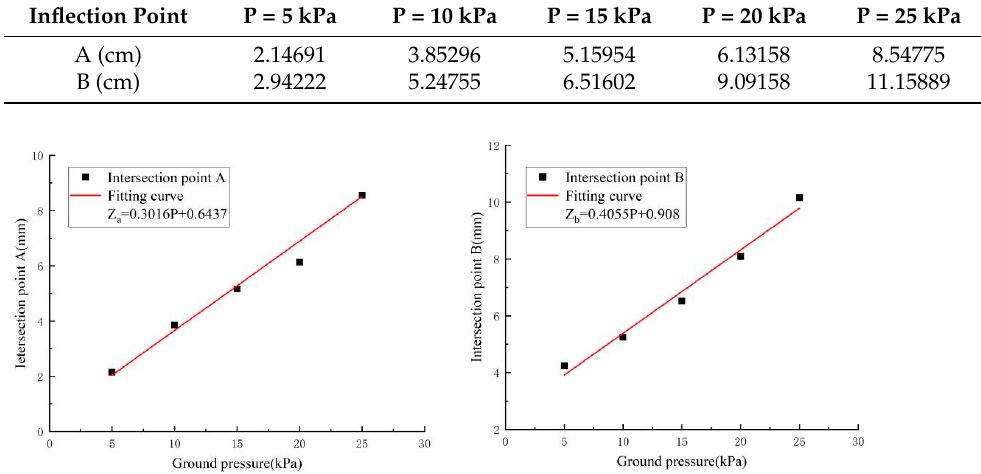
Table 1. The depths of inflection points A and B under various ground pressures [33].